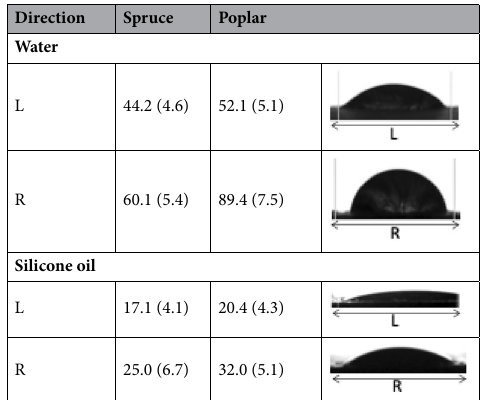
Table 1. Contact angles measured for two species (spruce and poplar) for two liquids (water and silicone oil). Values and (standard deviation) in degrees (photographs by G.